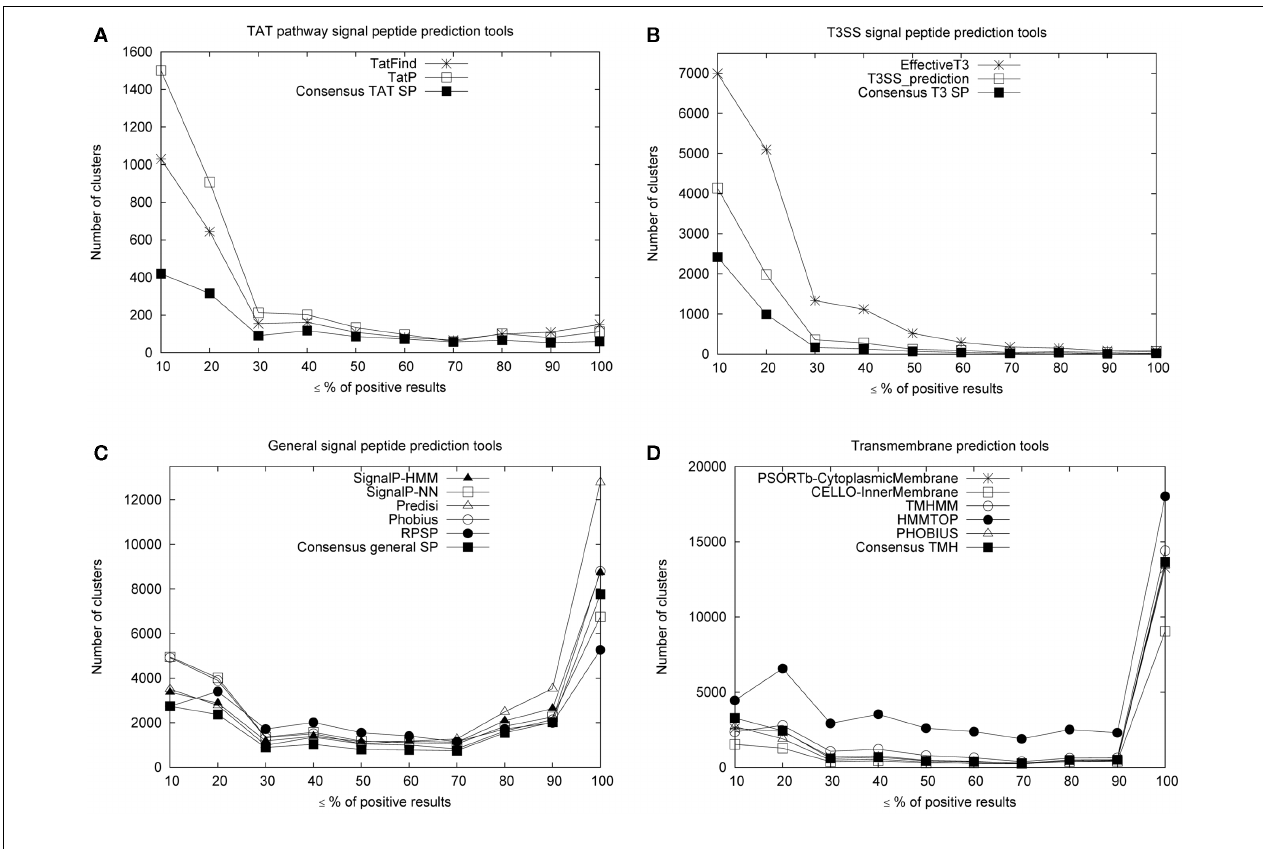
a signal peptide, where 10% means 0.1–10%, 20 means 10.1–20% etc. The majority of clusters contains only sequences where no signal sequence is predicted (0% positive results) – for clarity, these are ignored in the